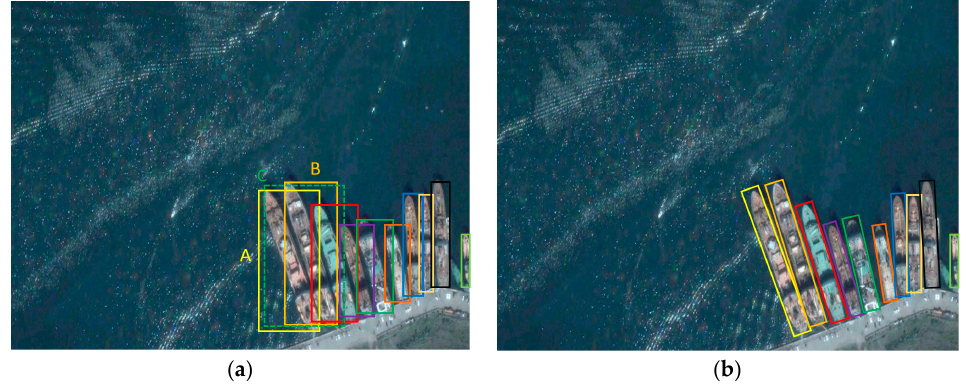
Figure 1. ( a ) Horizontal region detection with large redundancy region; bounding boxes A and B merge into C in the final prediction. ( b ) Rotation region detection with fitting detection region.